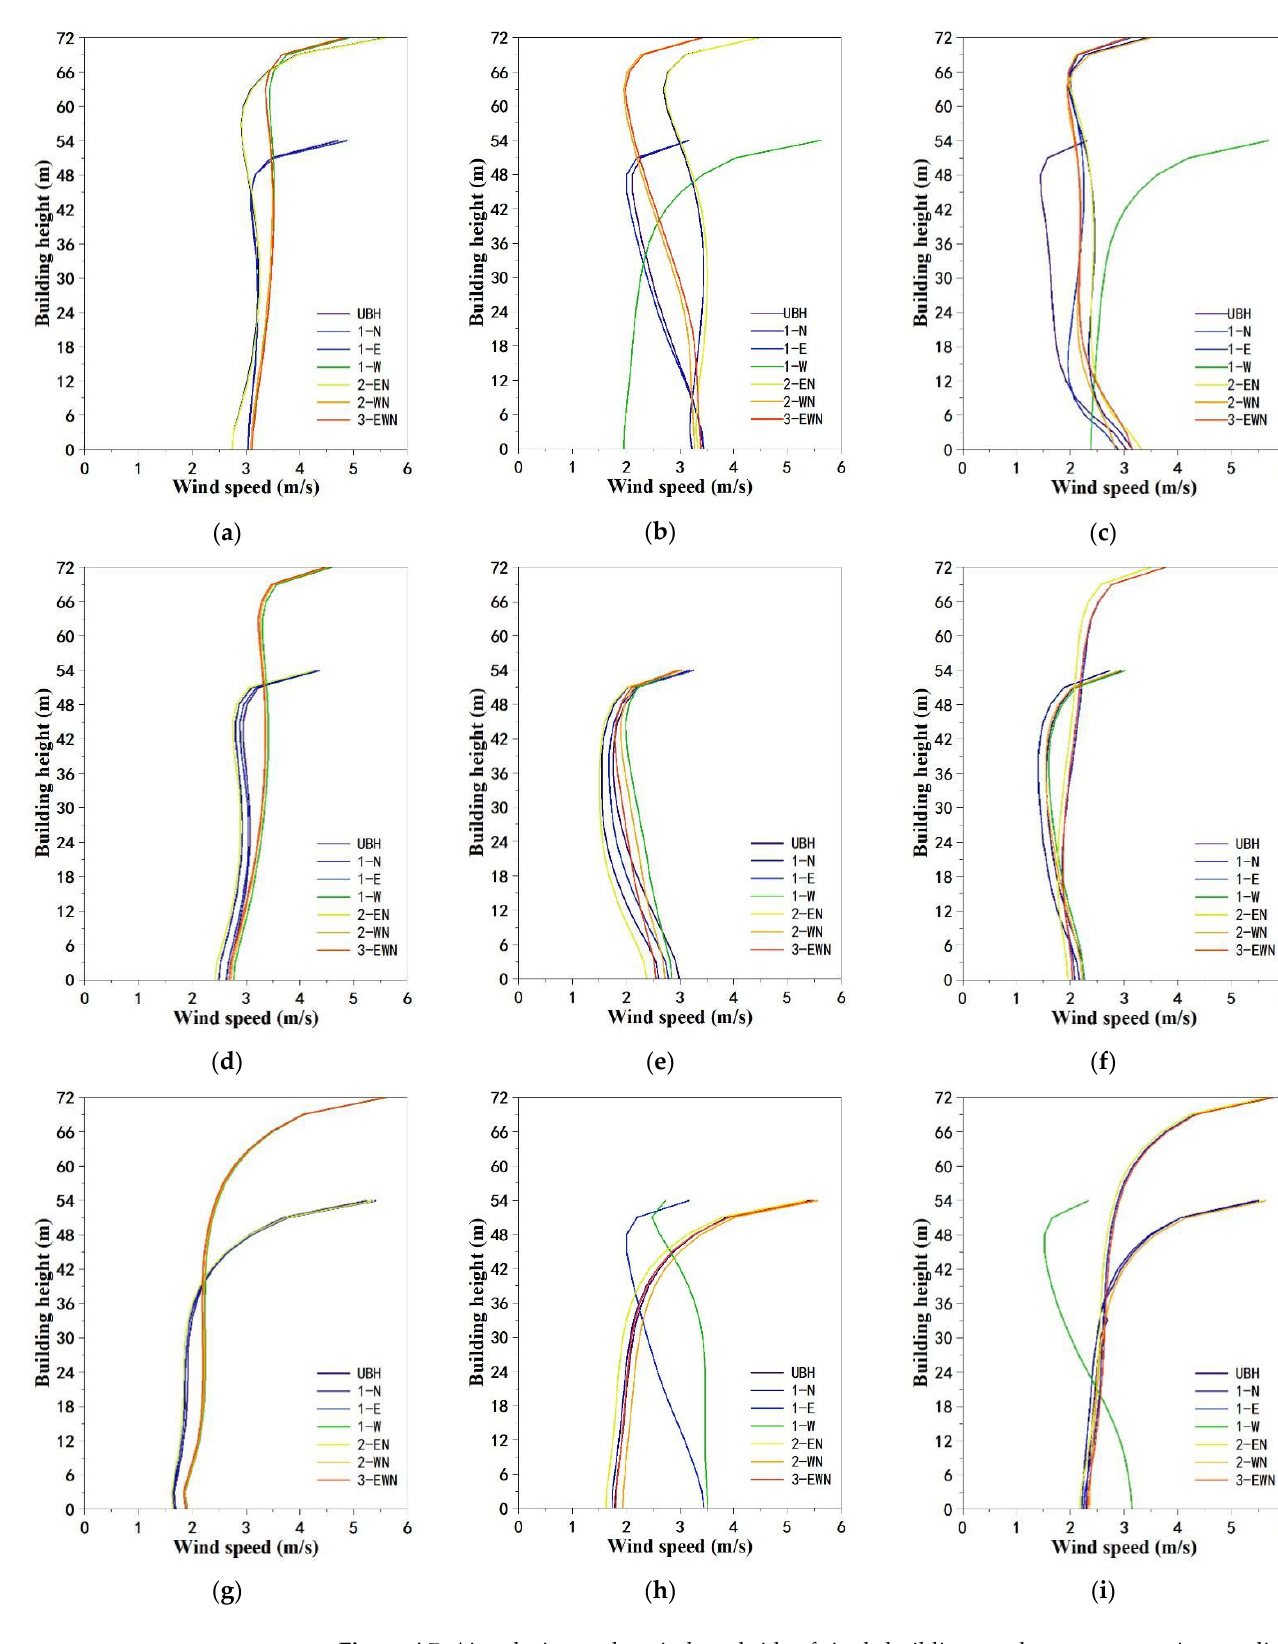
Figure A7. Air velocity on the windward side of single buildings under seven operating conditions;